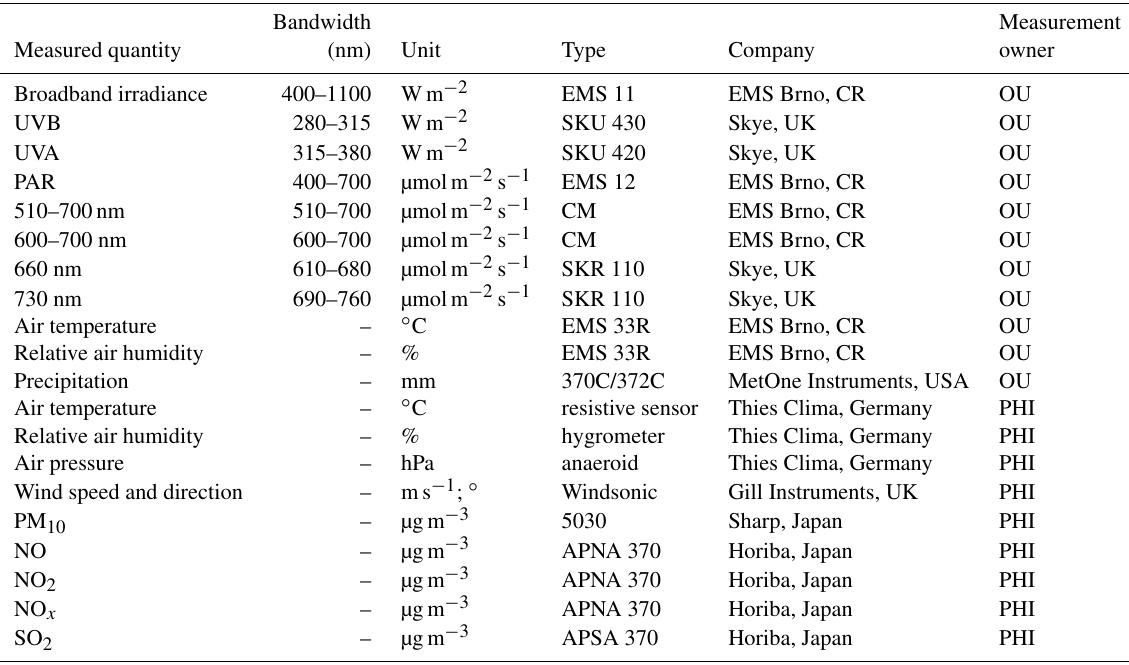
Table 3. Basic technical description of the sensors. Measurement owner: “OU” means University of Ostrava, these instruments were used at stations S1, S2, and S3. “PHI” means Public Health Institute Ostrava, these instruments were used at the measurement station of PHI. “CM” means custom made sensors.